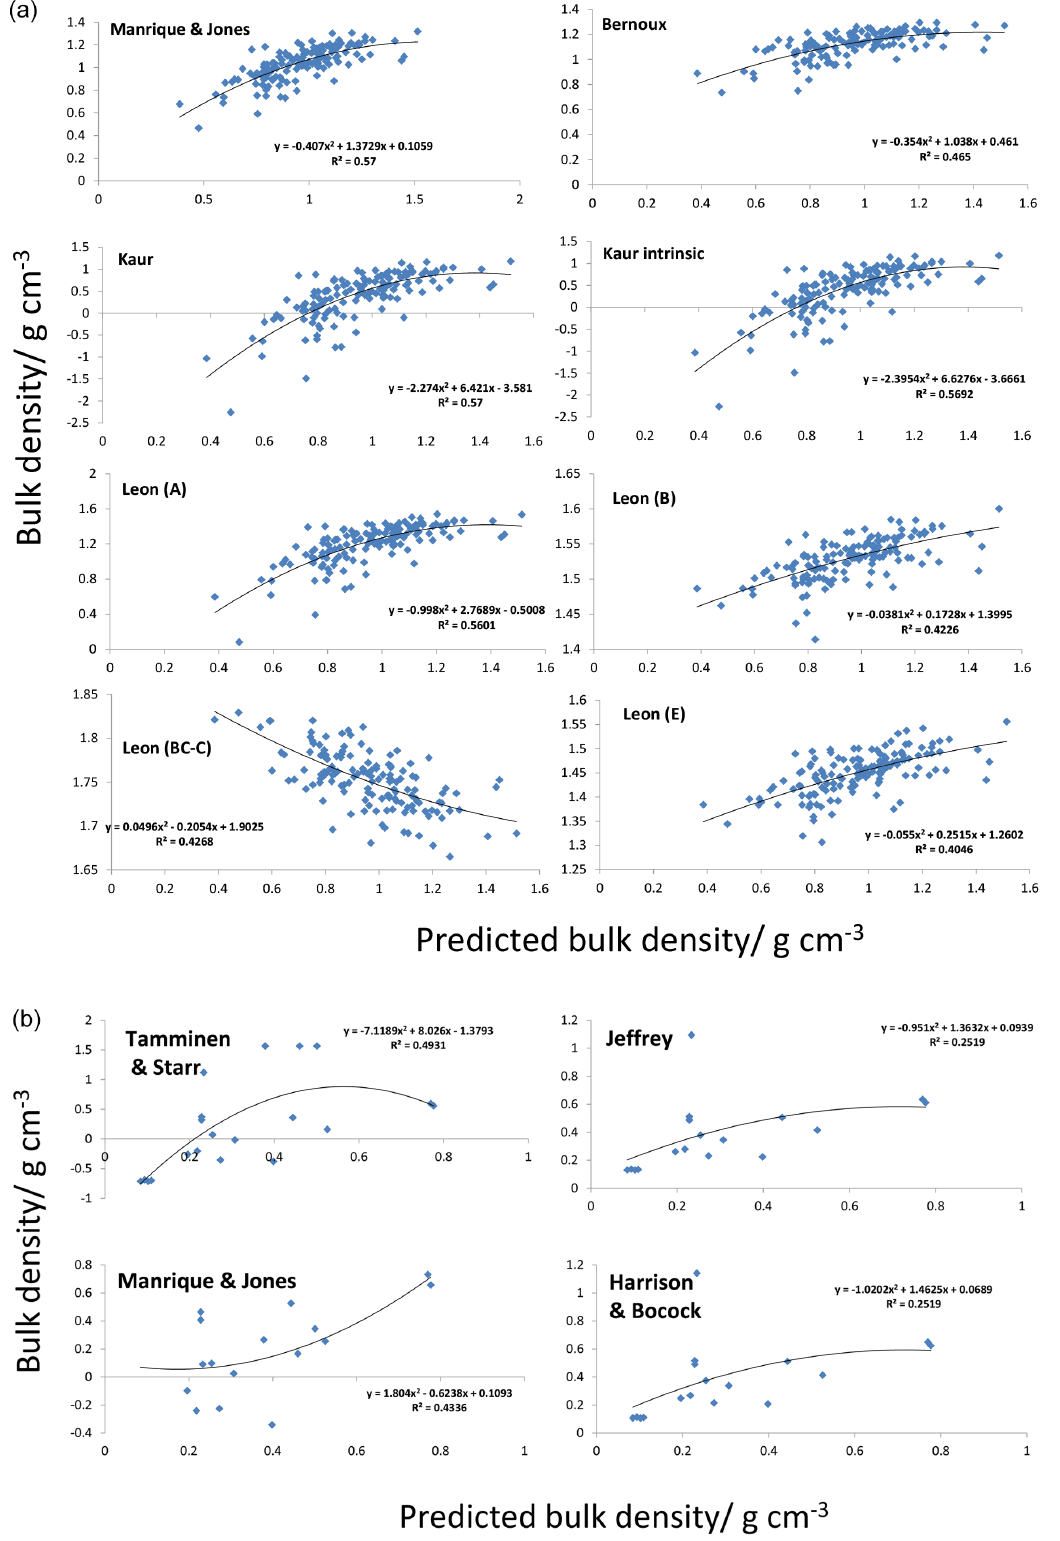
Figure 2. (a) Observed bulk density values for horizon Ap compared to prediction for original PTF formulae used indicating coefficient of variation equation and R 2 values. (b) Observed bulk density values for horizon O compared to prediction for original PTF formulae used indicating coefficient of variation equation and R 2